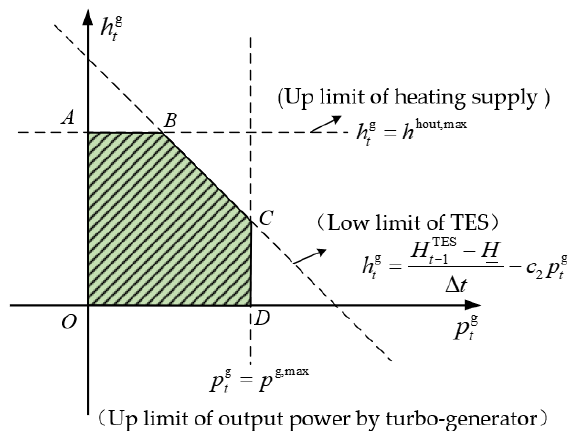
Figure 7. The operationally feasible region of the SA-CAES under discharging–heating mode.